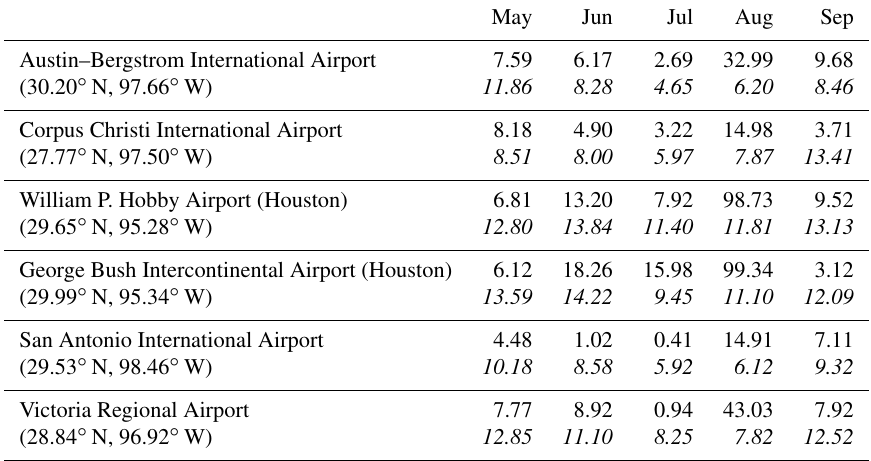
Table 1. Precipitation (cm) for sites in central Texas from May–September 2017 compared with the long-term mean (italics). Data down- loaded from https://www.srcc.tamu.edu/climate_data_portal/?product=precip_summary (last access: 7 July 2021).